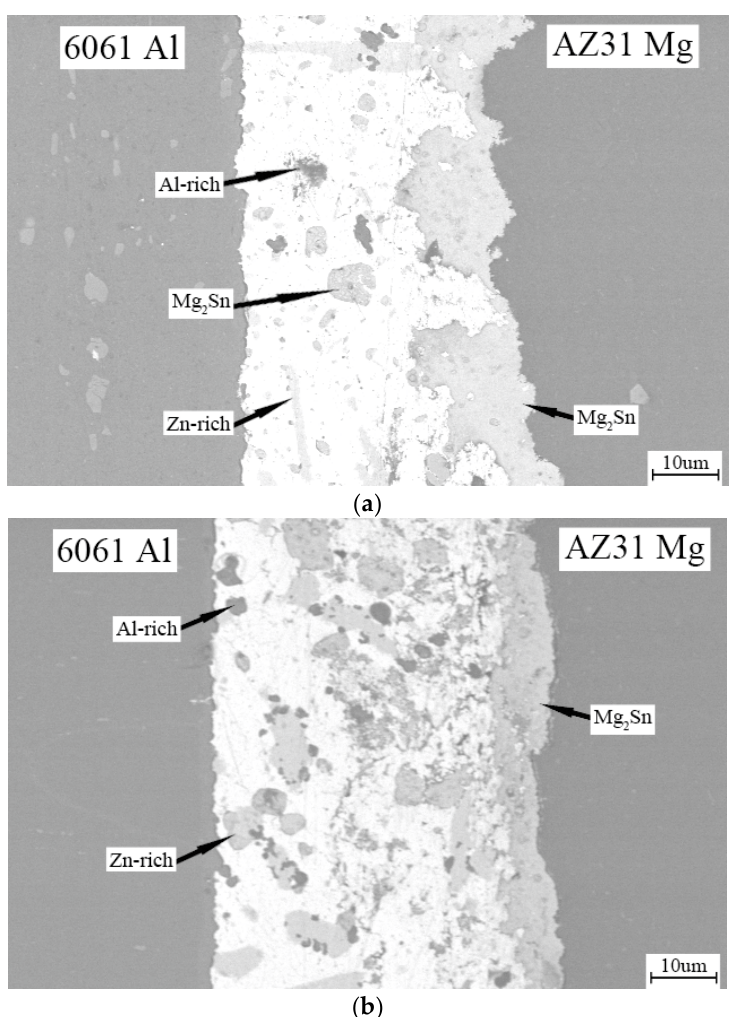
Figure 10. Cross-sectional SEM micrographs of the AZ31 magnesium/6061 aluminum alloy joints bonded with the Sn-10Zn-0.1RE filler metal after aging at 150 °C for ( a ) 50 h; ( b ) 100 h.